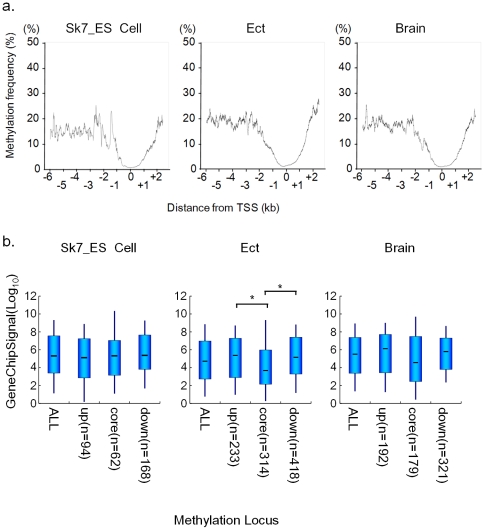
DNA methylation at transcription start sites (TSSs).a) DNA methylation frequency relative to the distance to the TSS. Methylation frequency was calculated using the following formula: Number of methylated probes/Number of total probes at each position from the TSS. The line indicates the moving average. b) Expression levels of genes associated with CMRs in each region around the TSS. The core region shows the region between 1 kb upstream and 0.5 kb downstream of the TSS. Up, indicates 1 kb<upstream from the TSS; down, indicates 0.5 kb<downstream from the TSS. The bold black lines denote medians; boxes denote interquartile ranges, and whiskers denote the 10th and 90th percentiles. (n, number of CMR associated genes) *: pair-wise comparisons of expression levels are significant (P<0.01, a t-test.).